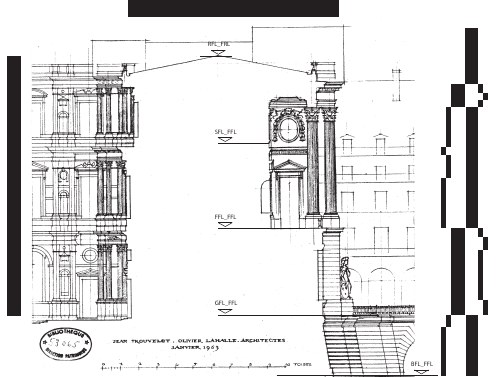
Figure 6: Trouvelot’s Section Through the Existing East Wing Annotated with the Horizontal Split